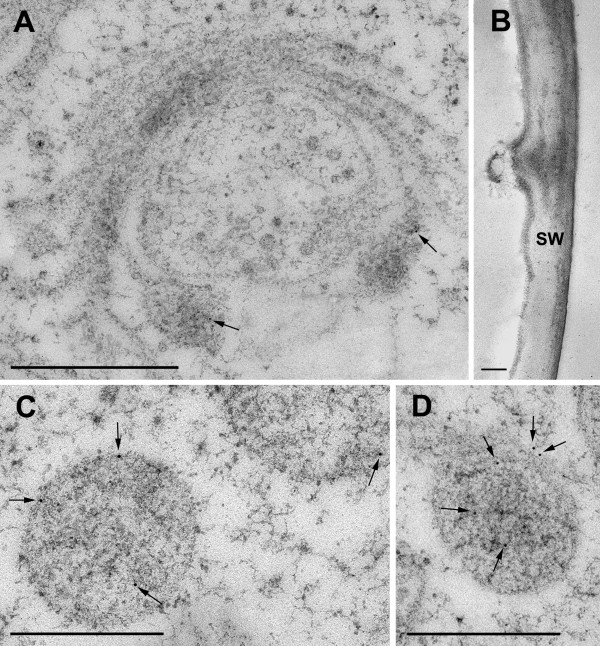
Immunogold labelling with anti-GFP antibody of high pressure-freeze fixed transiently MdEXP2-GFP-overexpressing Micrasterias denticulata interphase cells. (A) No staining of dictyosomal cisternae, fine staining of vesicles attached to the dictyosome (arrows). (B) Control staining with protein A-gold alone. No signal. SW, Secondary cell wall. (C, D) Staining of a mucilage vesicle released into the cytoplasm. Arrows indicate the label. Scale bar = 1 μm.